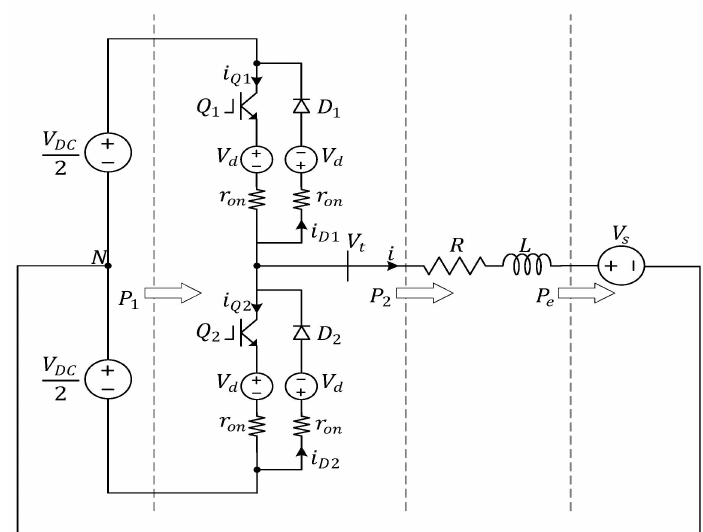
Figure 15. Nonideal half-bridge converter equivalent circuit. (b) Nonideal half-bridge converter average